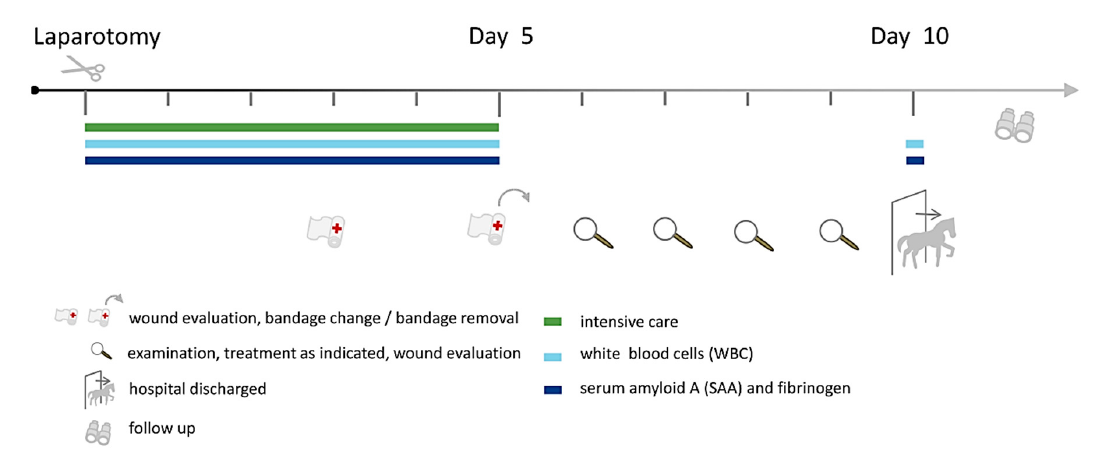
Figure 1. Illustration summarising the general post-surgical care and examinations applied to horses with colic surgery.